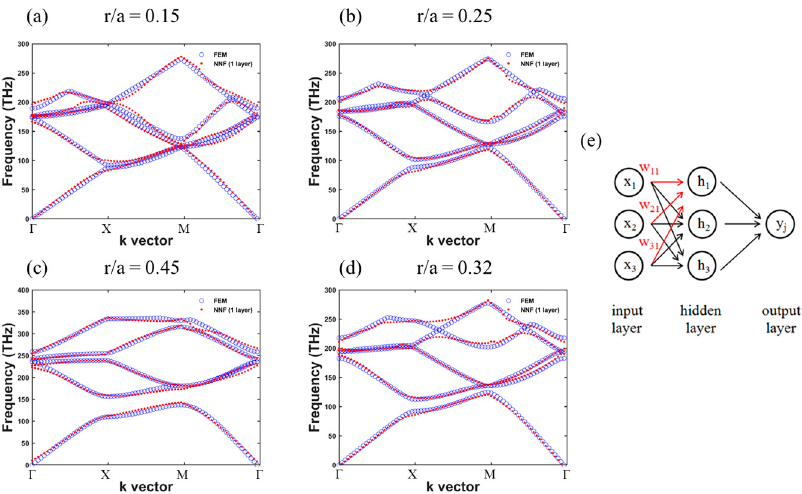
Figure 2. FEM-calculated (blue circles) and predicted (red dots) band structures of square lattice photonic crystals with r/a = ( a ) 0.15, ( b ) 0.25, ( c ) 0.45, and ( d ) 0.32. ( e ) Sketch of artificial neural network.